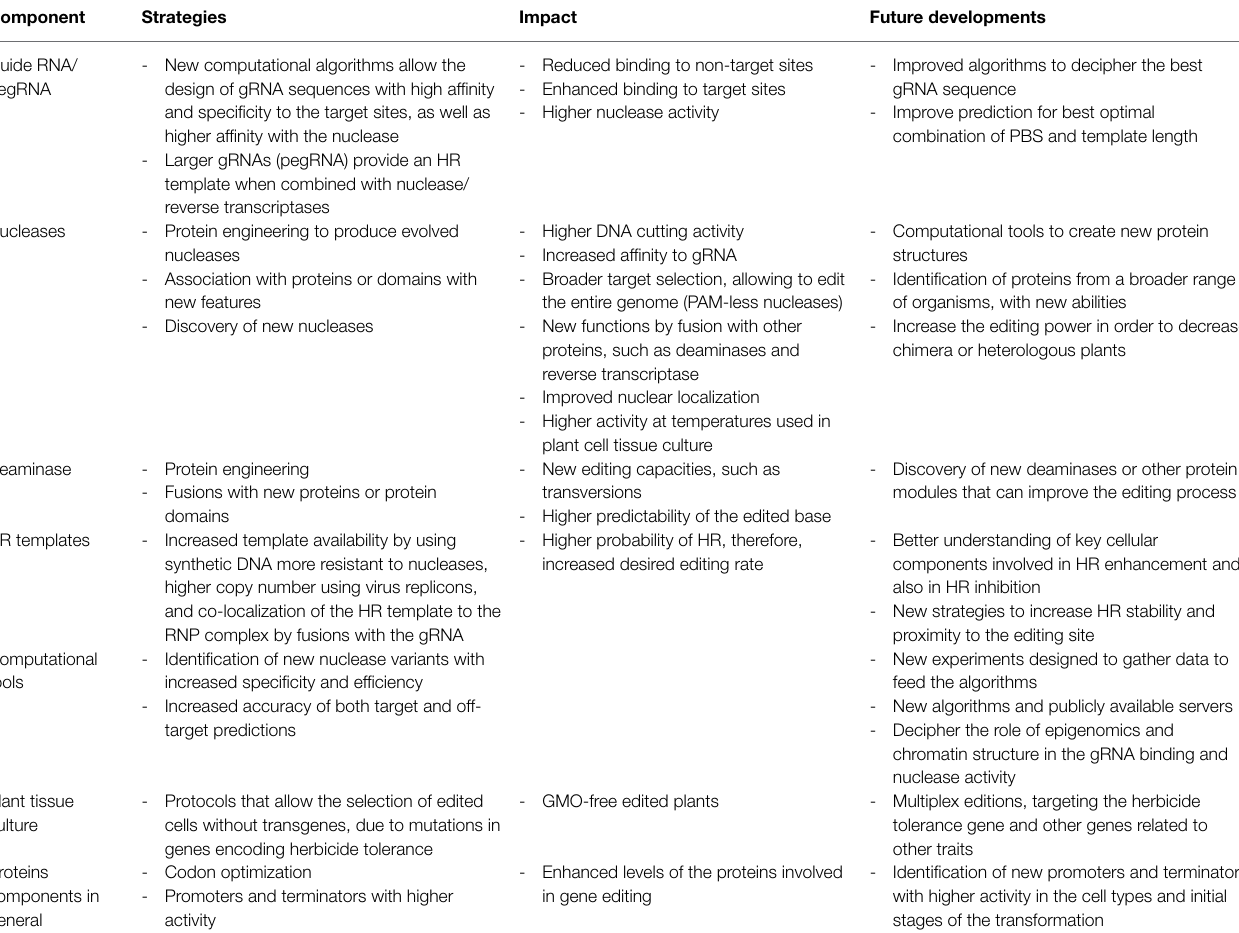
TABLE 1 | Overview of tools and techniques to increase genome editing efficiency.